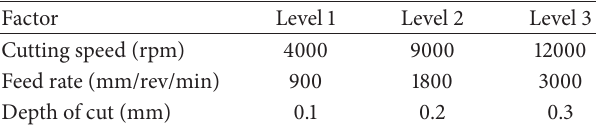
Table 1: Factor and levels for testing for stainless steel.